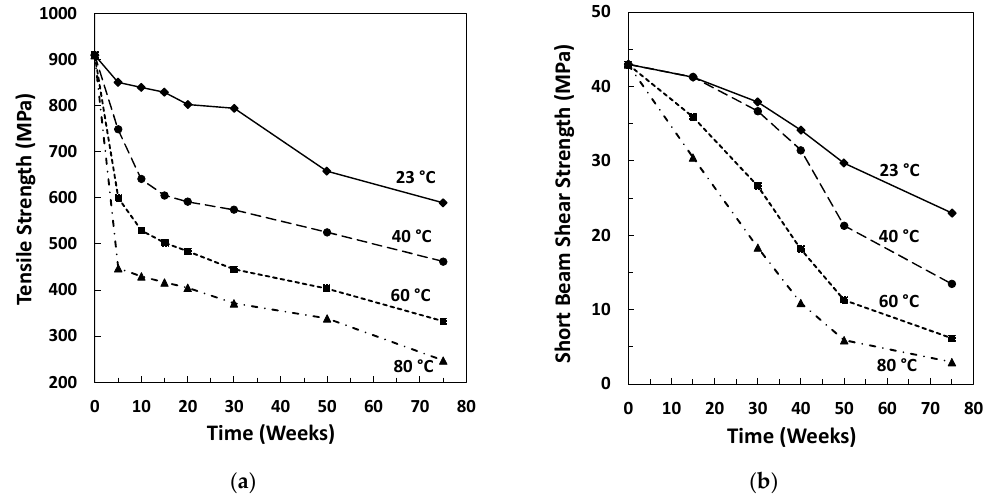
Figure 1. Effect of hydrothermal ageing in deionized water at different temperatures on the mechanical properties of pultruded glass fibre-reinforced vinyl ester composites ( a ) Tensile strength; ( b ) Short beam shear strength. Reprinted/adapted with permission from Ref. [46]. 2004, Elsevier Ltd.